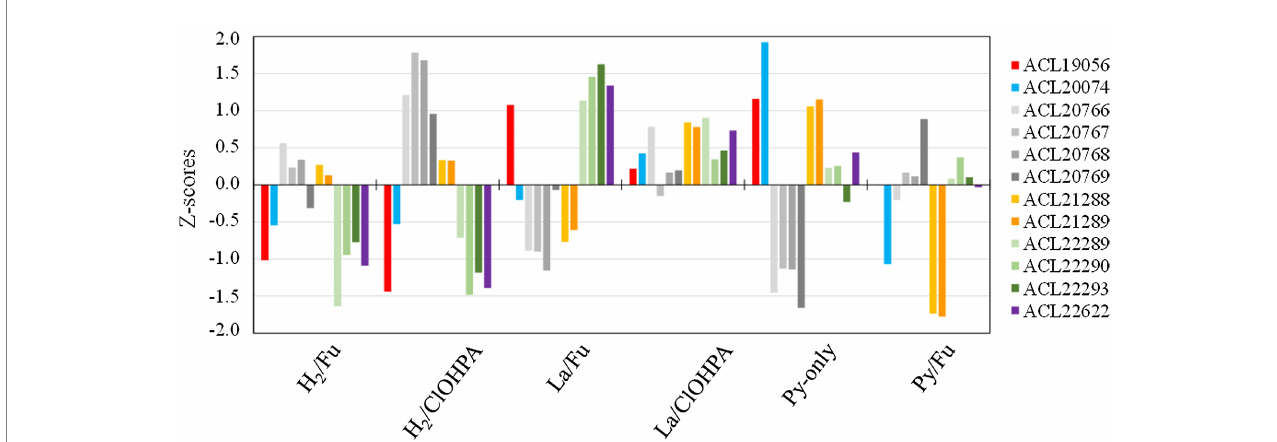
FIGURE 5 Z-scores of the hydrogenases from Desulfitobacterium hafniense strain DCB-2 detected across the six growth conditions. Twelve subunits from six different hydrogenases (out of nine) were detected in the proteomic dataset. The subunits belonging to the same hydrogenase are displayed in different shades of the same